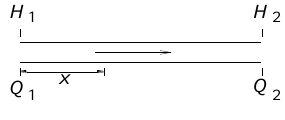
Figure 2. Pipe segment.